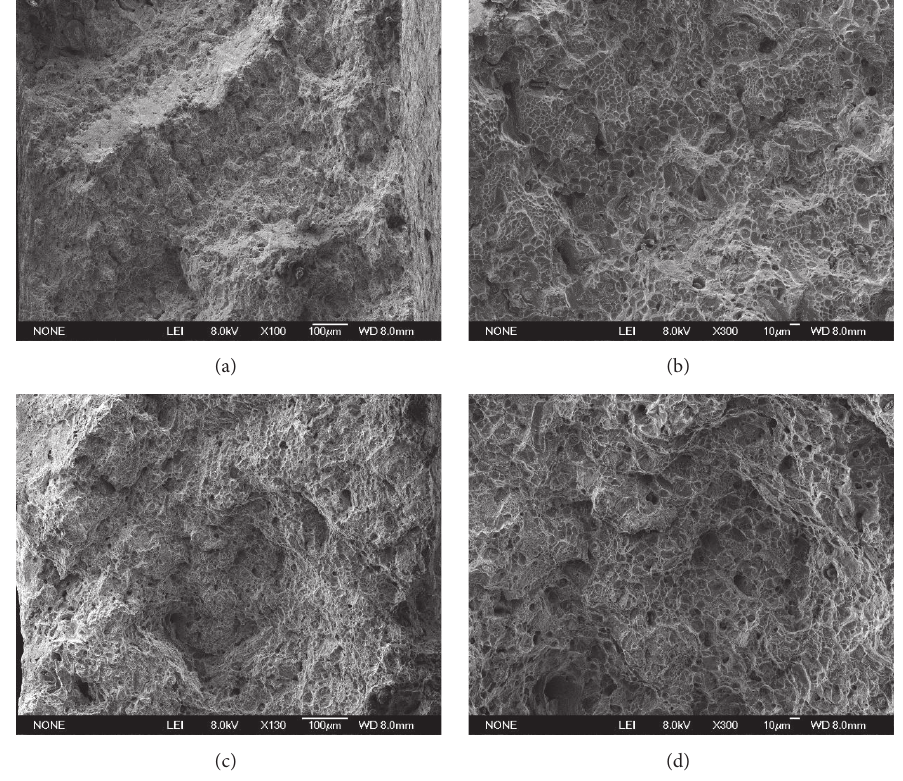
Figure 10: The fracture appearance of 1045 carbon steel without and with annealing at 873 K (600 ∘ C) for different time: macrograph (a) and microscopy (b) of cast steel; macrograph (c) and microscopy (d) of the steel annealed at 873 K (600 ∘ C) for 4 h.